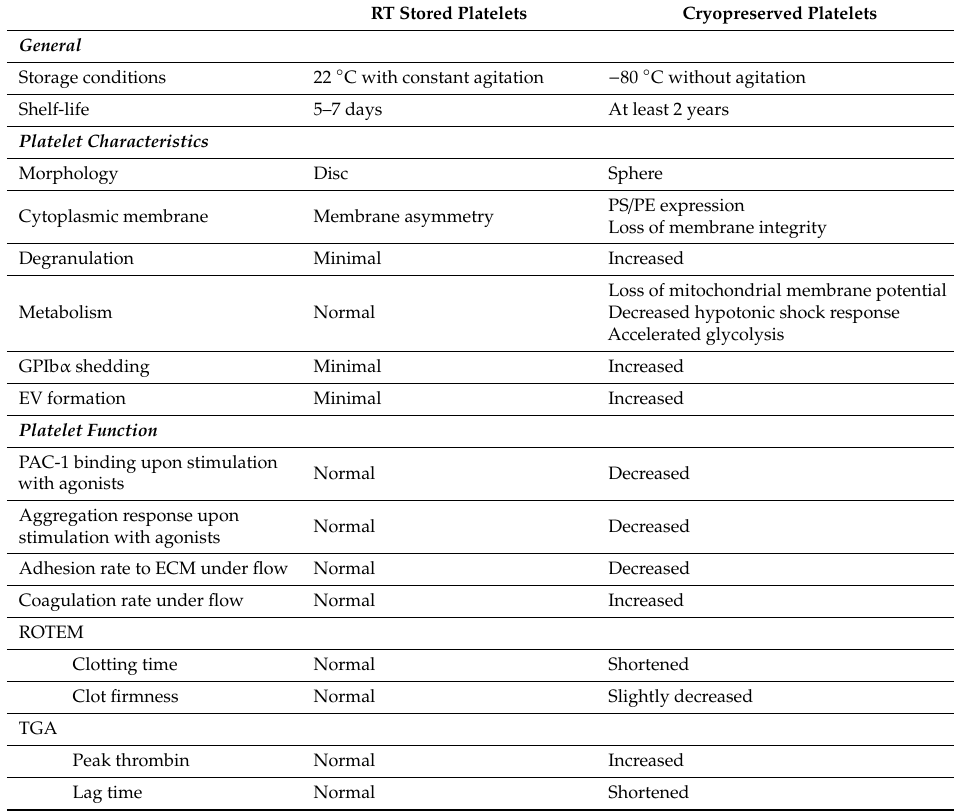
Table 1. Summary of morphologic and biochemical characteristics and their impact on platelet function of RT stored or cryopreserved